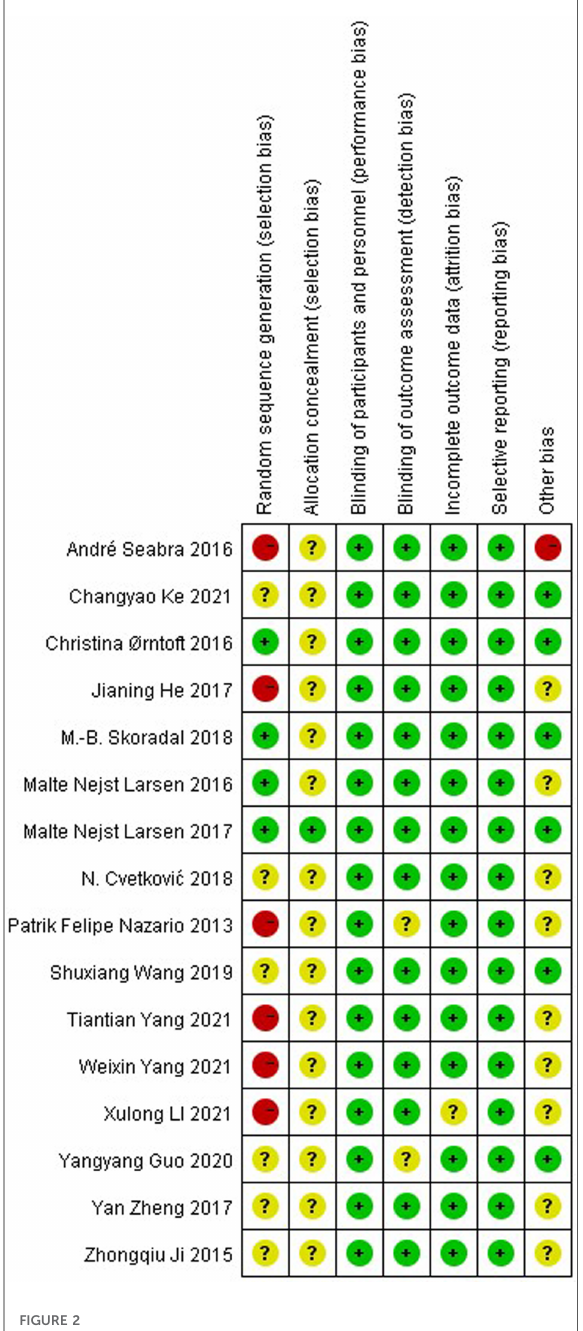
FIGURE 2 Risk of bias graph of the included